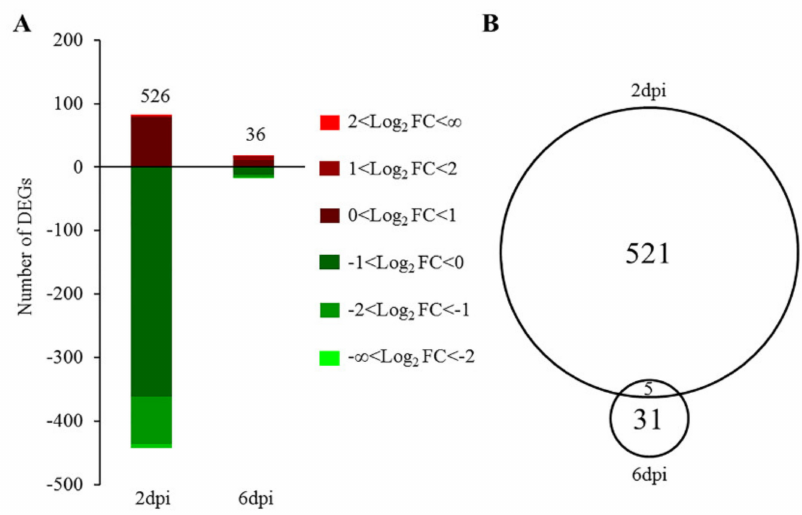
Figure 3. Number of significant di ff erentially expressed genes (DEGs) for NDV-challenged vs non-challenged birds at false discovery rate < 0.05. ( A ) Histogram showing the number of DEGs at 2 and 6 days post inoculation (dpi), and their distribution. Up-regulated and down-regulated DEGs are represented in red and blue color. DEGs within di ff erent ranges of Log 2 fold change are represented in di ff erent brightness of the color. ( B ) Venn diagram showing the number of overlapping DEGs at 2 and 6